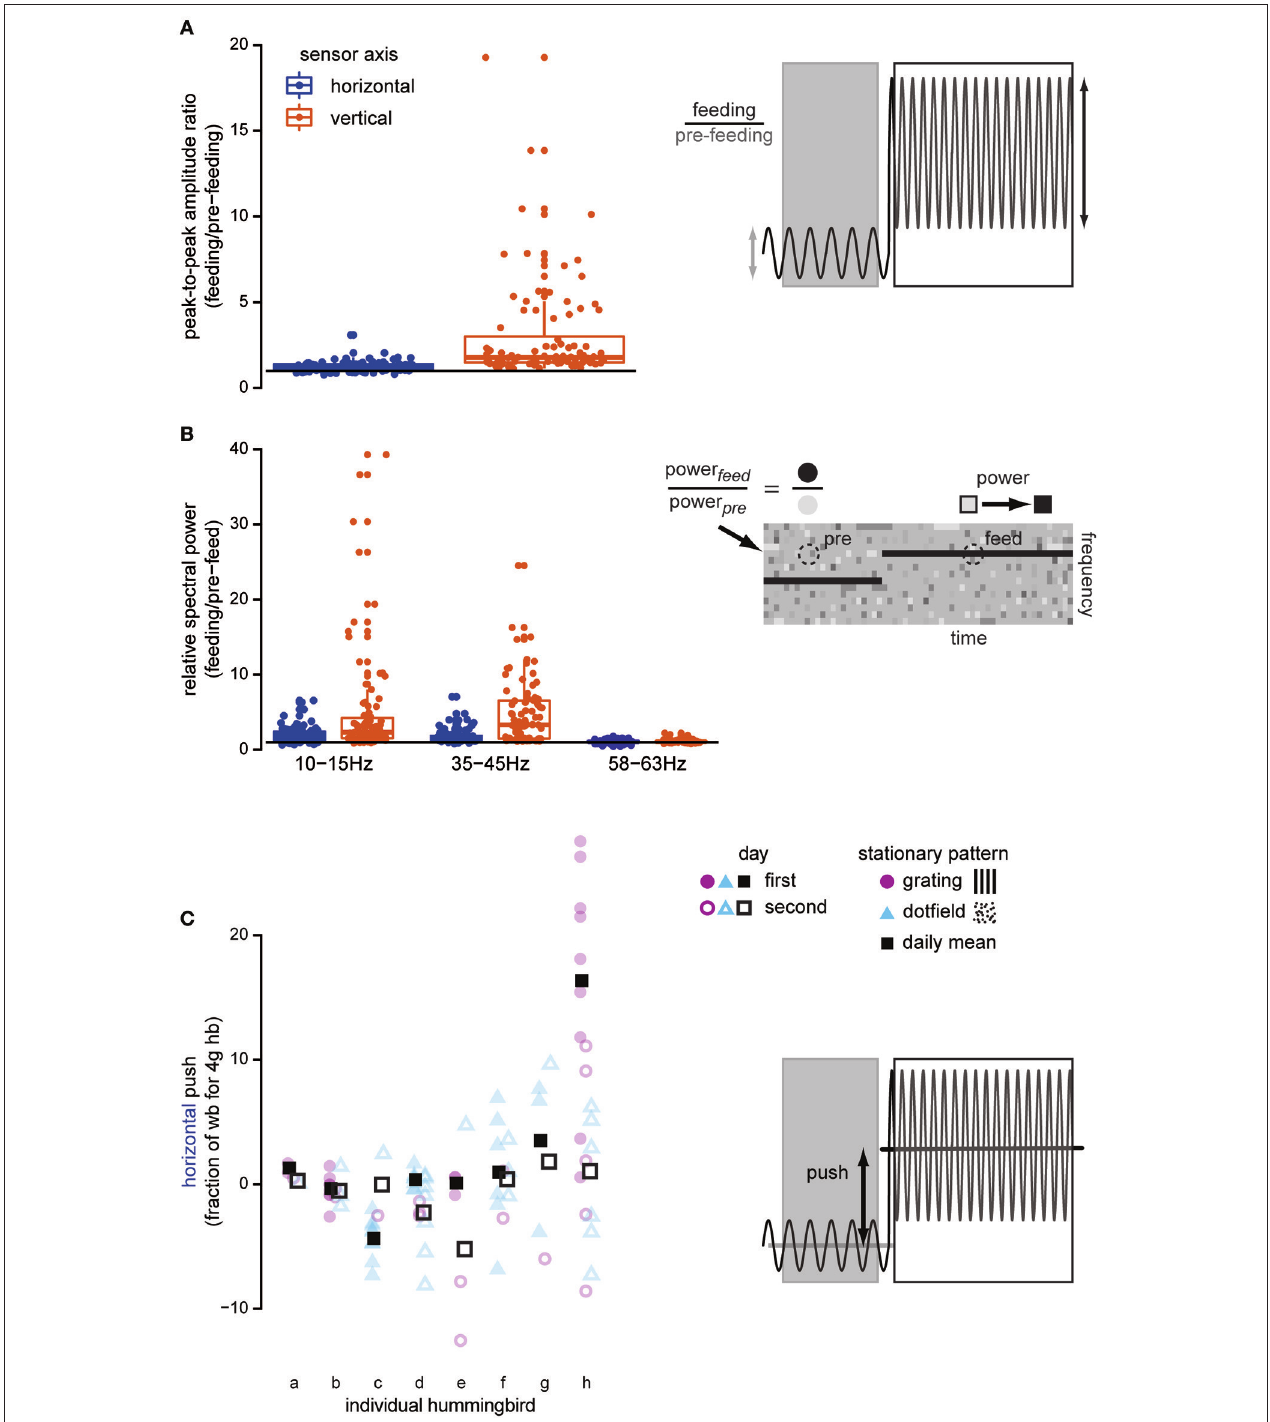
FIGURE 2 | Docked hummingbirds interact with the feeder. Data shown here are from trials where stationary dot-fields and gratings are presented. Once the bird docks, both the amplitude and the frequency of oscillations in the force signals increase above background noise levels, indicating that the feeding hummingbird is exerting forces on the feeder. The peak-to-peak amplitude of the recording (A) increases when the hummingbird docks, especially in the vertical axis (copper). The horizontal line illustrates a ratio equal to 1, indicating no change in the signal after the bird has docked. We compared the spectral power of various frequencies in the feeding and pre-feeding strain measurements (B) to determine if behaviorally relevant frequencies changed once the hummingbird docked (visually illustrated by comparing the colors of the dotted circle regions). Our measurements exhibit signatures of two behaviorally relevant frequencies: licking frequency (10–15Hz) and